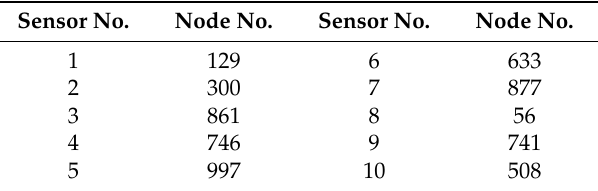
Table 5. Sensor placement